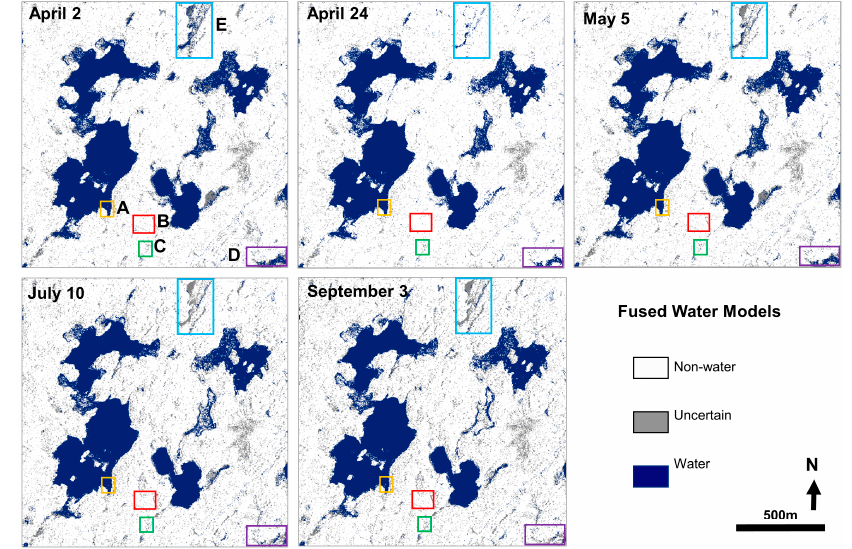
Figure 10. Five fused water models created for the five SAR acquisition dates: 2 April, 24 April, 5 May, 10 July, and 3 September 2016. The three classes shown are non-water (white), uncertain (grey), water (blue). Rectangles outline the five study sub-areas.